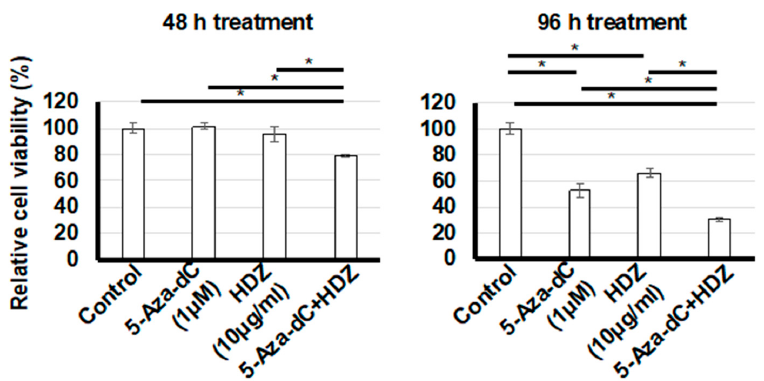
Figure 1. Proliferation of HSC-T6 cells (hepatic stellate cells) treated with 5-aza-2 ′ -deoxycytidine (5- aza-dC), hydralazine (HDZ), and 5-aza-dC and HDZ combined. Cell proliferation was measured using the WST1 assay. The effects of 5-aza-dC, HDZ, and combined treatment with 5-aza-dC and HDZ were compared with untreated control cells. Data are the mean ± SD (n = 3). * p < 0.01 vs. the untreated control.